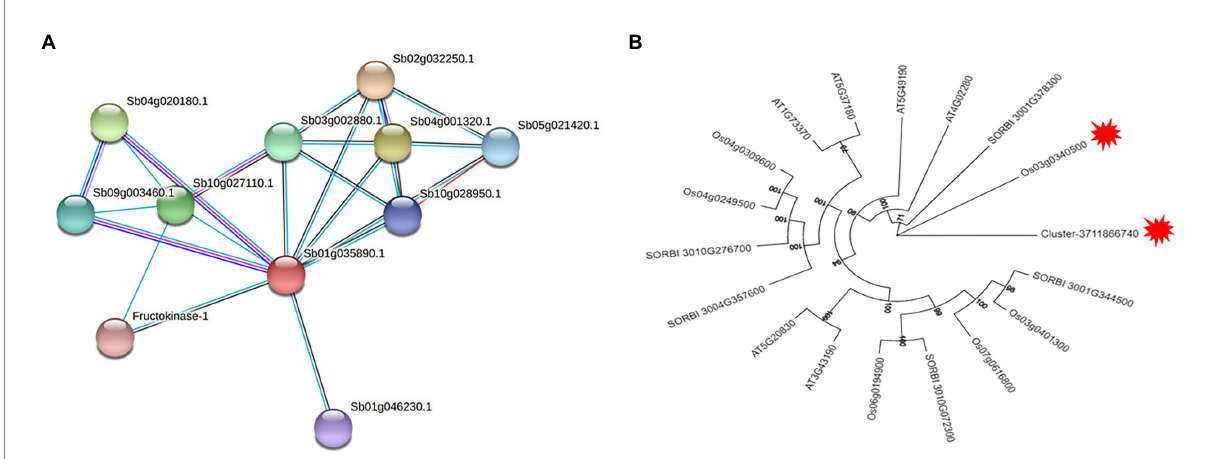
FIGURE 9 (A) Sb01g035890.1 protein interaction network. The red node in the figure is the sorghum protein Sb01g035890.1 aligned by Cluster-37118.66740, the red line represents gene fusion, the cyan line is from the database, the pink line is the experimental proof result, the black line is the co- expressed protein, and the blue line represents the gene symbiotic relationship; (B) Phylogenetic Analysis of sucrose synthase gene